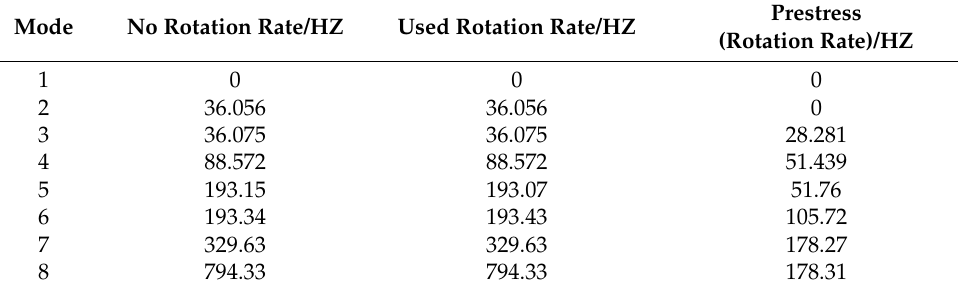
Table 3. With or without rotation rate, M134 fundamental frequency.